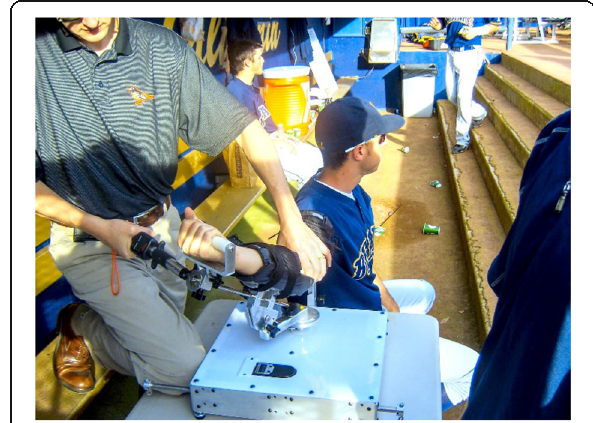
Fig. 3 Testing volunteer with the Elbow